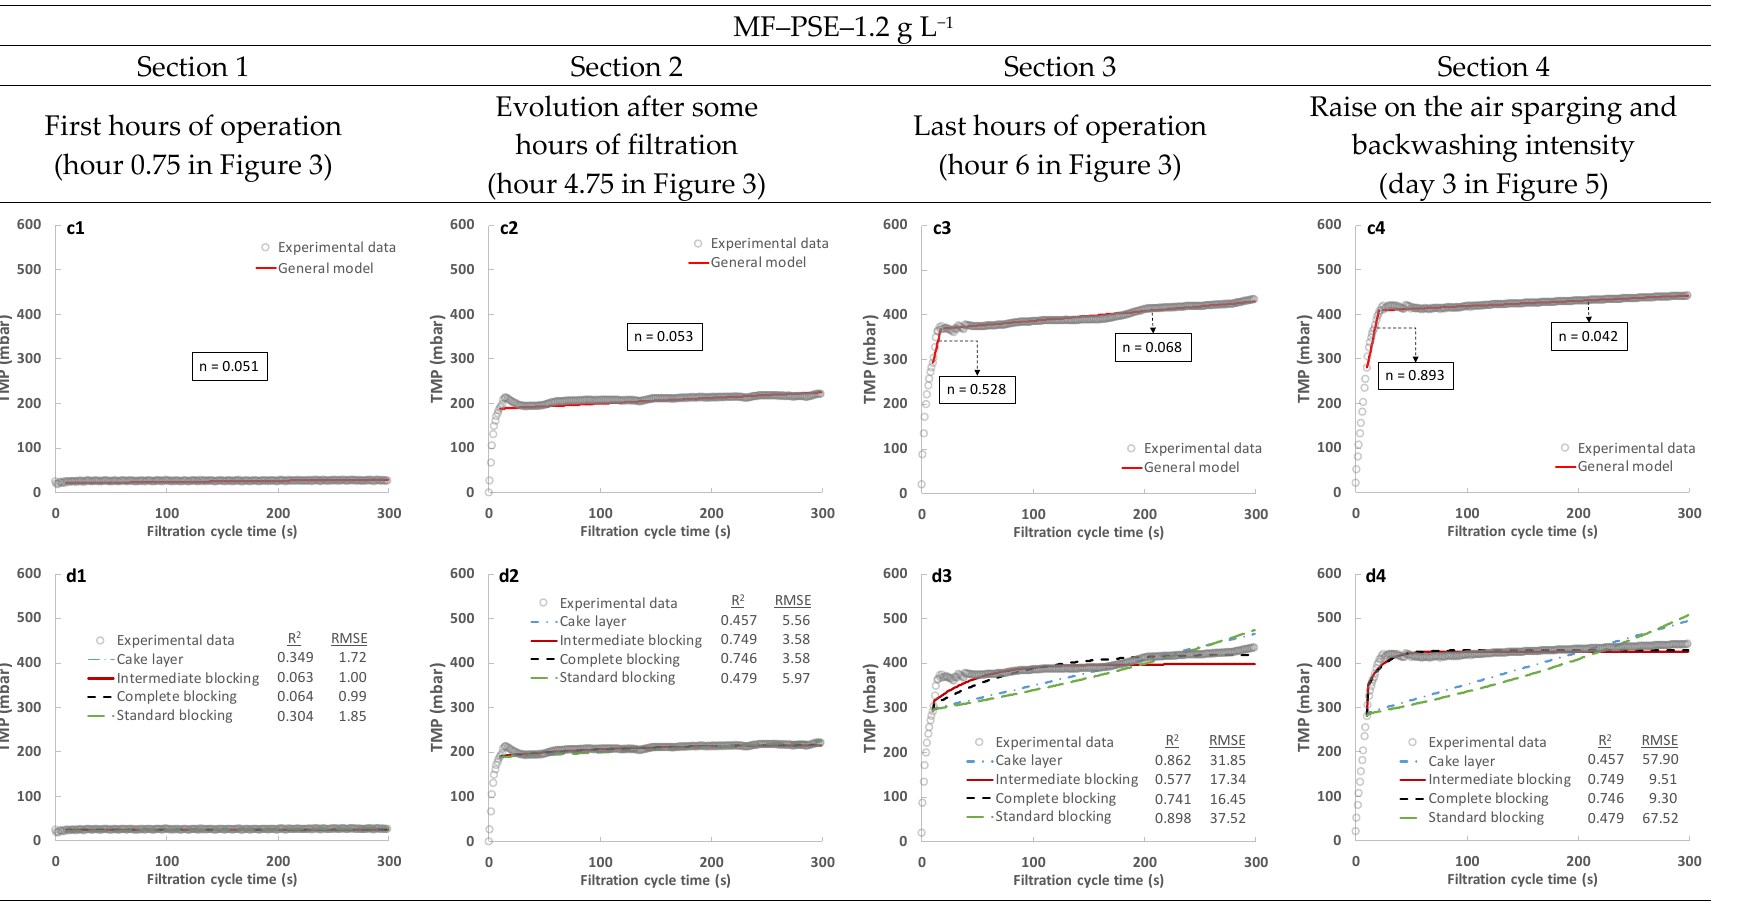
Figure 7. Examples of the fouling mechanism study for the TMP evolution during independent filtration cycles: ( a , c ) general model; ( b , d ) cake layer, intermediate blocking, complete blocking and standard blocking models. R 2 and RMSE represent the square of the Pearson correlation and the root-mean-square error, respectively. PSE: effluent of the full-scale wastewater treatment plant primary settler.